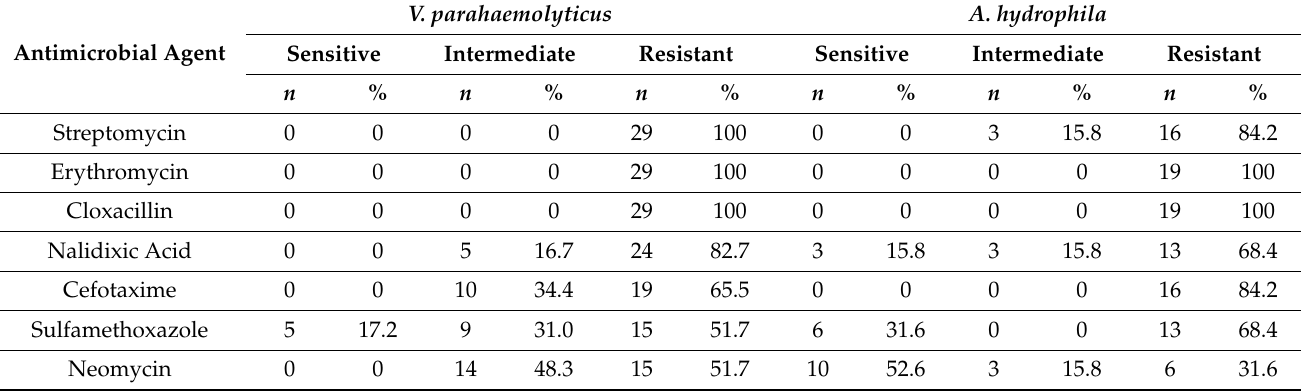
Table 2. Antibiotic susceptibility of V. parahaemolyticus ( n = 29) and A. hydrophila ( n = 19). V. parahaemolyticus A. hydrophila Antimicrobial Agent Sensitive Intermediate Resistant Sensitive Intermediate